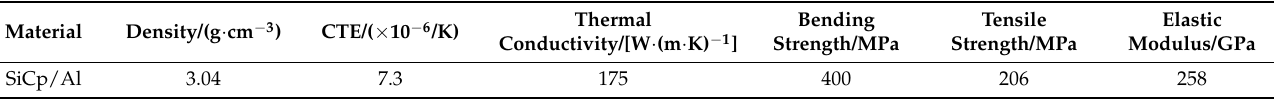
Table 1. Physical properties of